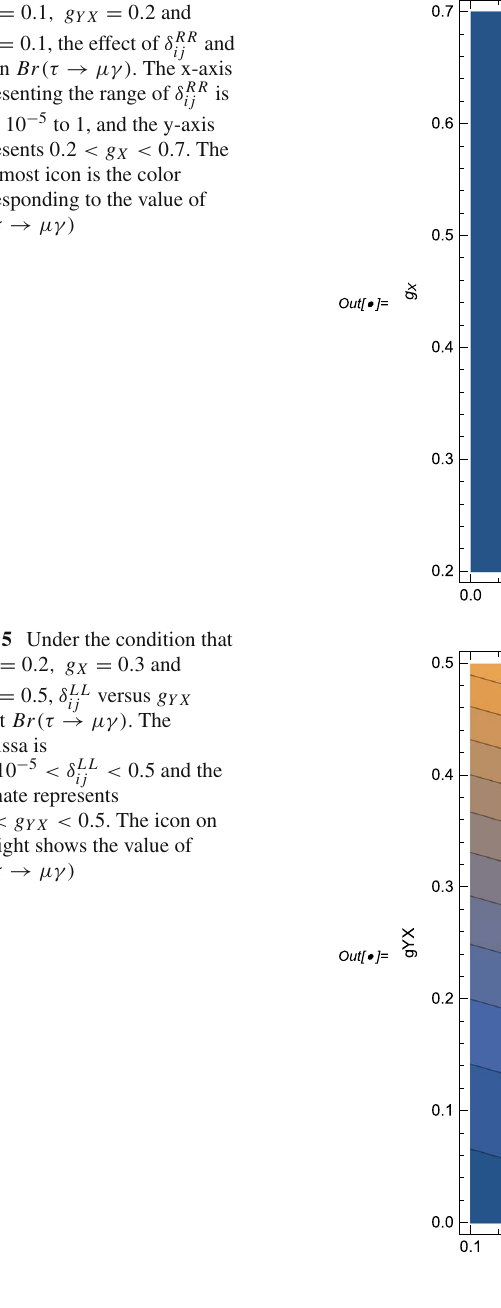
Fig. 4 Under the condition that δ LR = 0 . 1 , g = 0 . 2 and YX ij δ LL = 0 . 1, the effect of δ RR and ij ij g X on Br (τ → μγ) . The x-axis representing the range of δ RR is ij from 10 − 5 to 1, and the y-axis represents 0 . 2 < g X < 0 . 7. The rightmost icon is the color corresponding to the value of Br (τ → μγ)